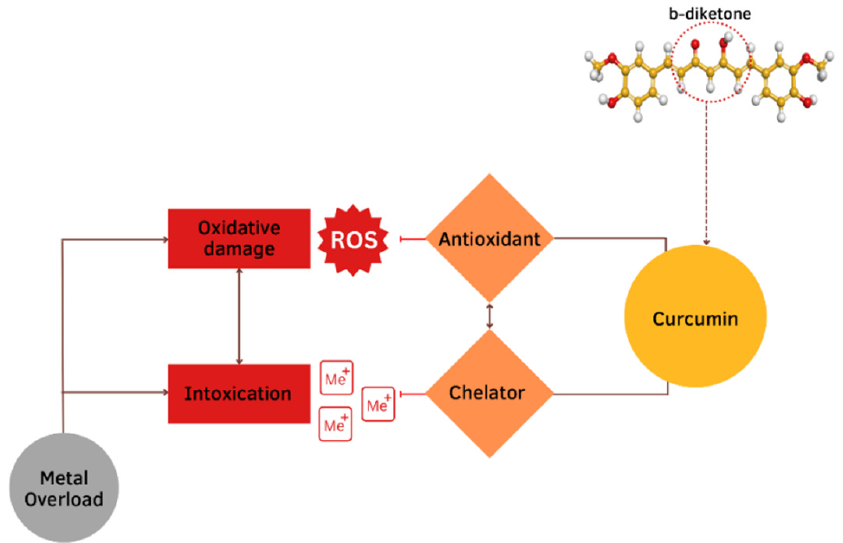
Figure 5. Mechanisms of the protective effects of CUR against metal toxicity. The protective effect of CUR is ascribed to its neutralization of free radicals and chelating properties. This is achieved primarily due to the presence of a